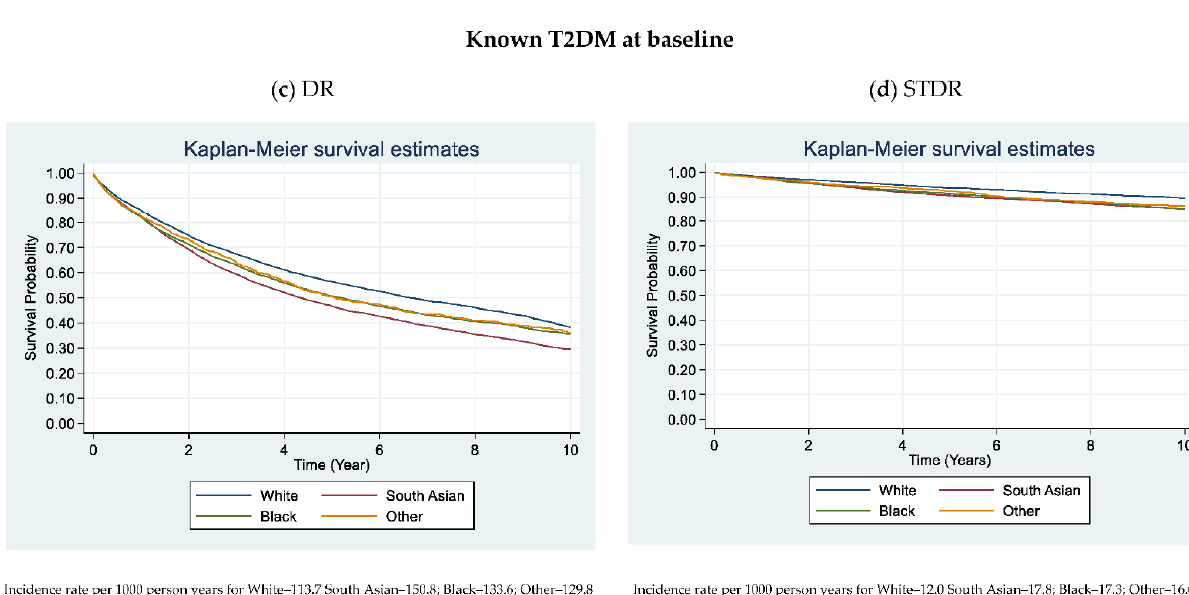
Figure 1. Kaplan-Meier Survival Estimates for DR and STDR.